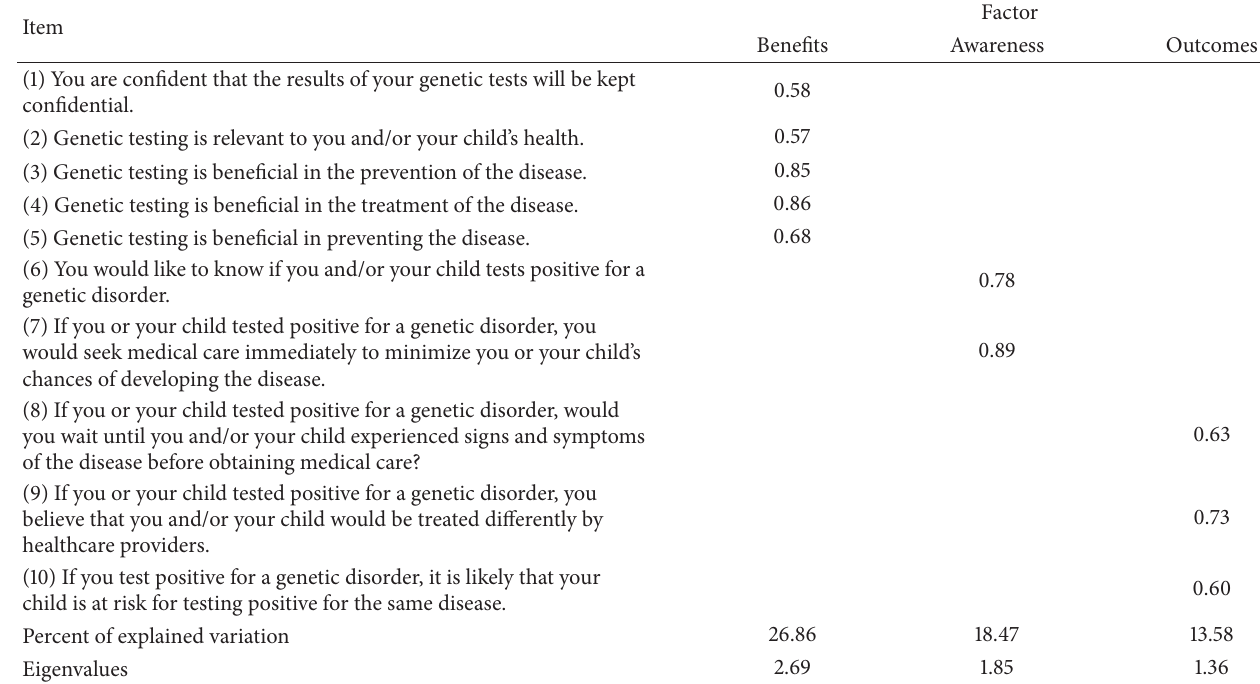
Table 1: Principal components factor analysis of “Attitudes toward genetic testing